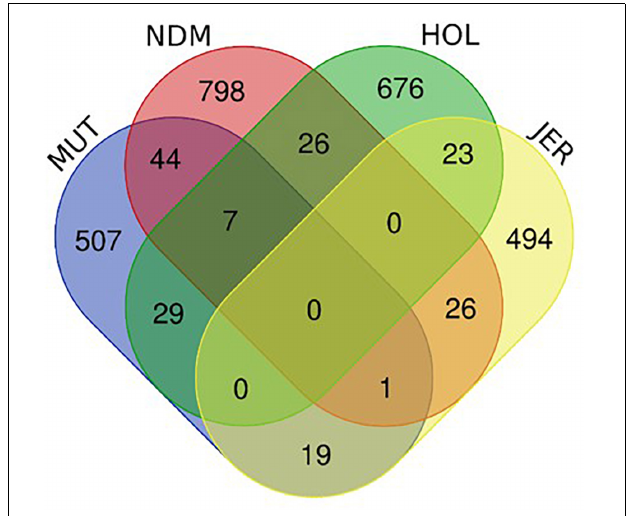
FIGURE 10 | Venn diagram showing unique and shared candidate genes identified in candidate regions under selection ( iHS and Rsb ) in Muturu (MUT), N’Dama (NDM), Holstein (HOL), and Jersey